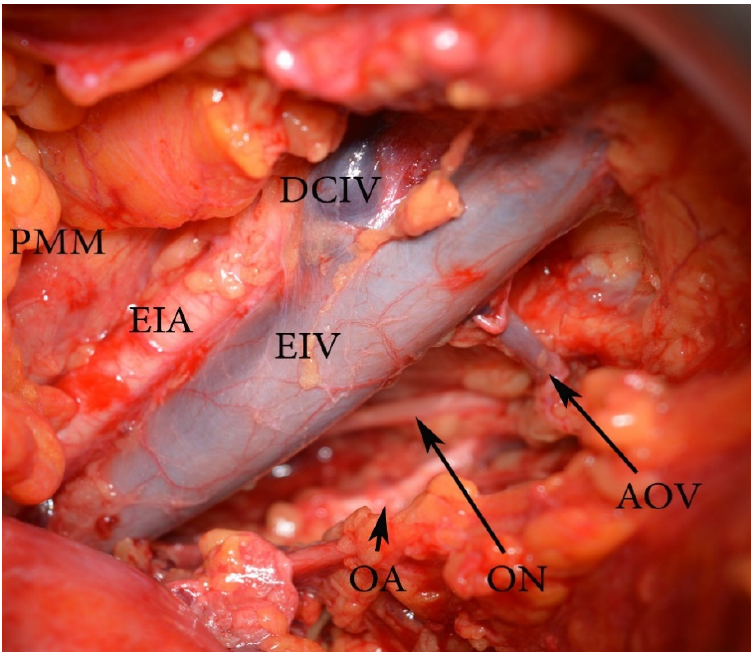
Figure 19 . An aberrant obturator vein (left pelvic sidewall). EIA—external iliac artery, EIV—external iliac vein, PMM—psoas major muscle, AOV—aberrant obturator vein, ON—obturator nerve, OA—obturator artery, DCIV—deep circumflex iliac vein.